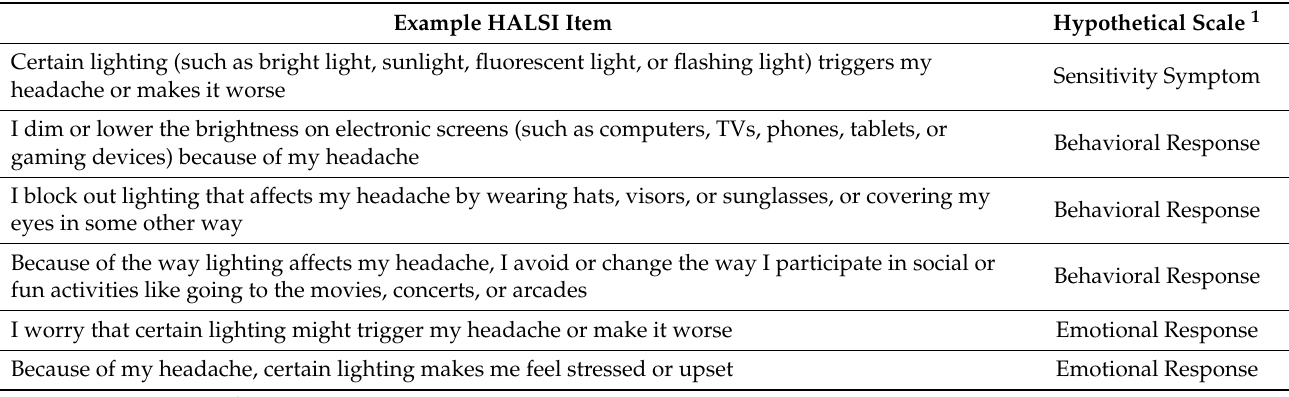
Table 1. Subset of items for proposed inclusion in the